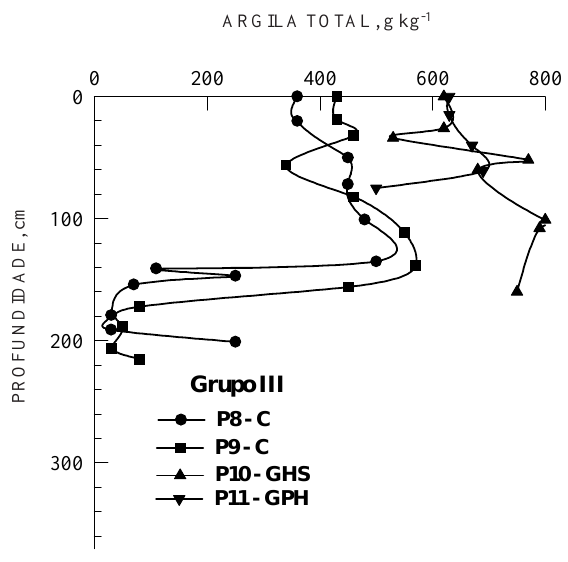
Figura 6. Curvas de distribuição da argila total em profundidade nos perfis desenvolvidos de sedimentos aluviais.